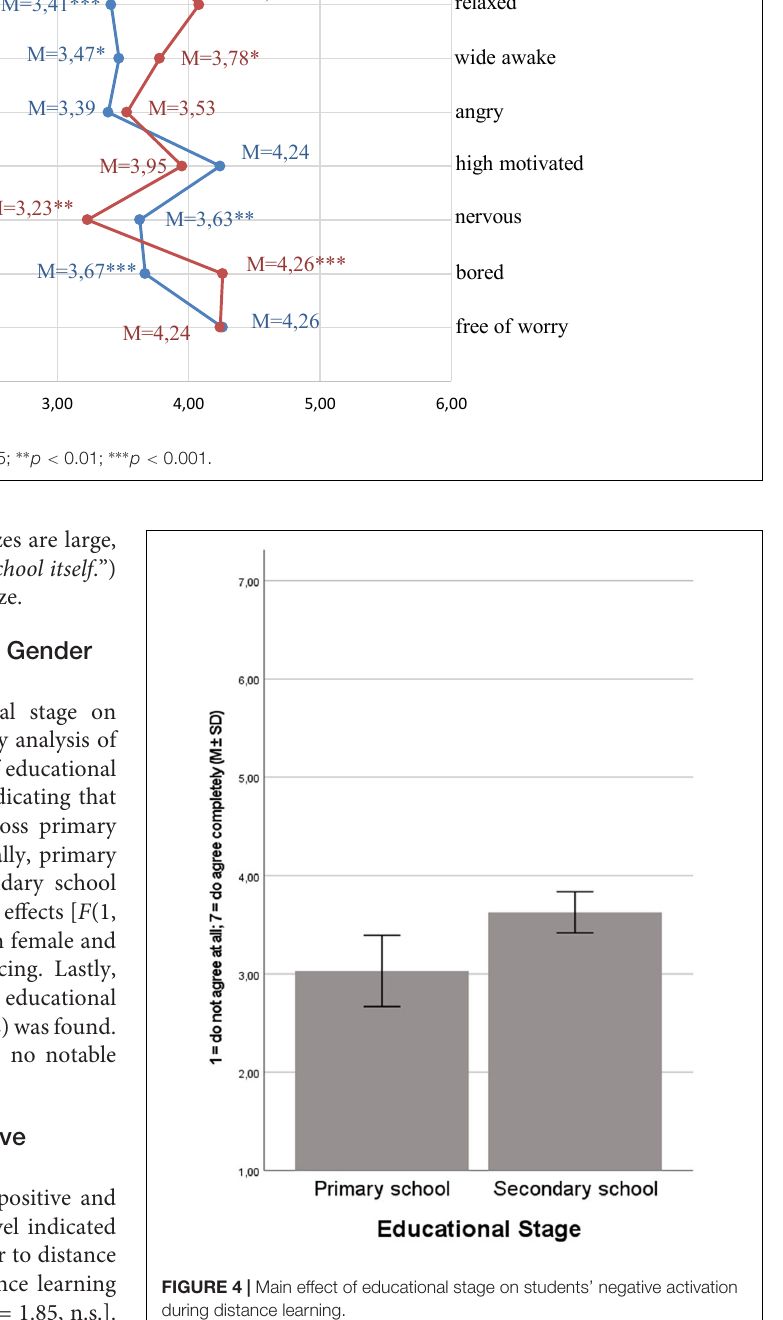
FIGURE 4 | Main effect of educational stage on students’ negative activation during distance